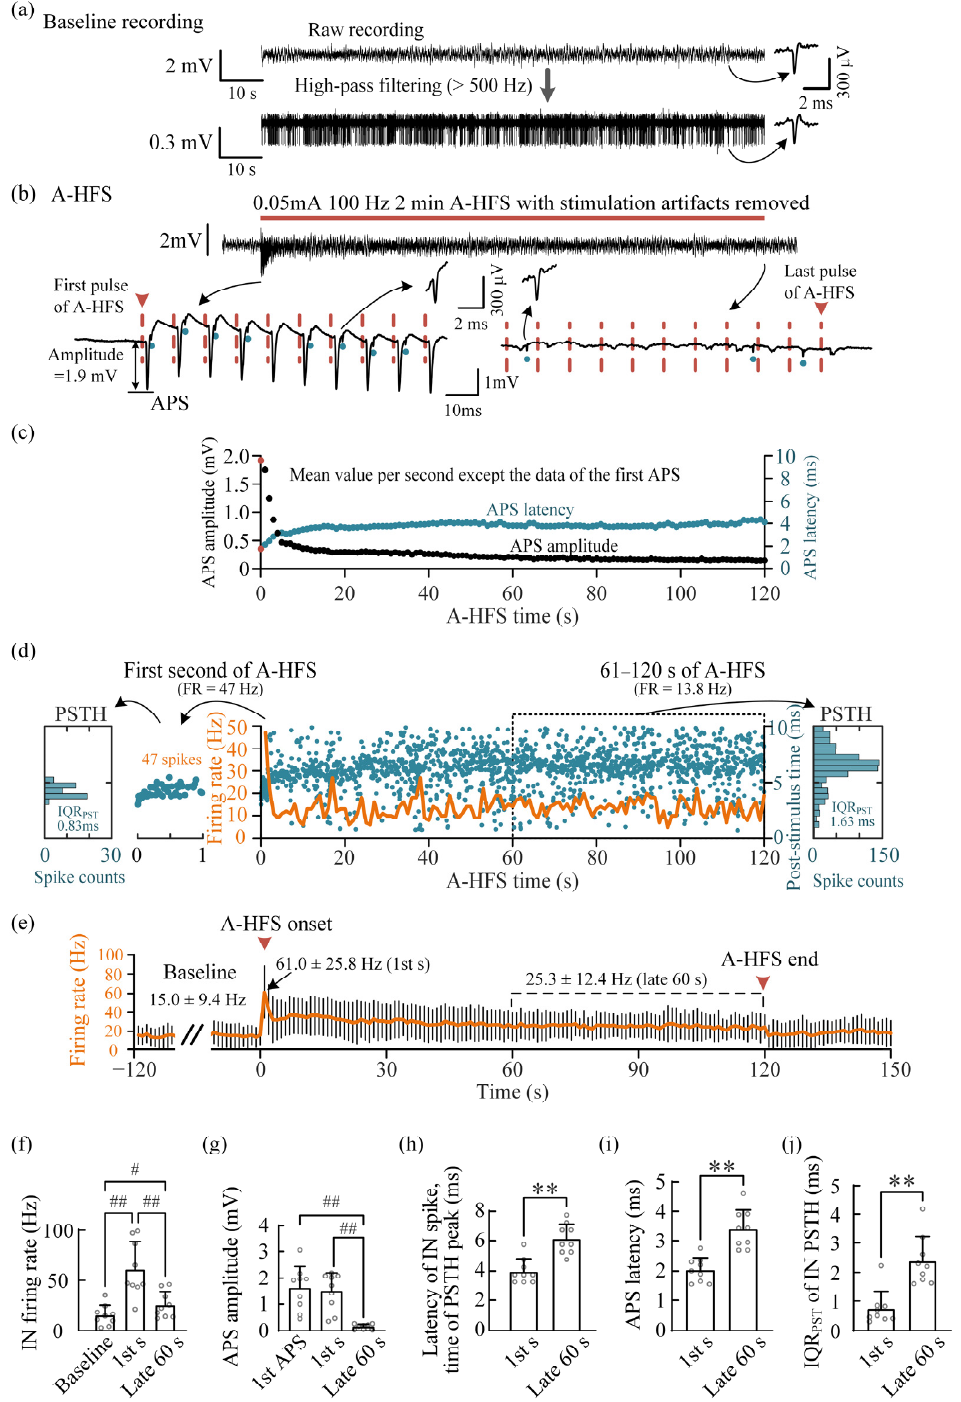
Figure 2. Modulating the firing of IN in the feedback circuit by weak A-HFS at the efferent axons of the hippocampal CA1 region. ( a ) Baseline recording and its high-pass filtered signal with obvious unit spikes of an IN. ( b ) Evoked APS and IN spikes during A-HFS. The red horizontal bar denotes the A-HFS period and the dashed vertical lines denote the stimulation pulses. The blue dots mark the unit spikes of IN. ( c ) Scatter plots of the amplitudes and the latencies of evoked APSs during A- HFS. Except for the data of the first APS (red dots), the other data were the mean values per second. ( d ) Two-dimensional raster plot of the unit spikes of IN firing during A-HFS (blue dots) together with its firing rate (FR) per second (orange curve). The post-stimulus time histogram (PSTH) plots of the 1st second and of the late 60 s (61–120 s) of A-HFS are shown on the left and right, respectively.